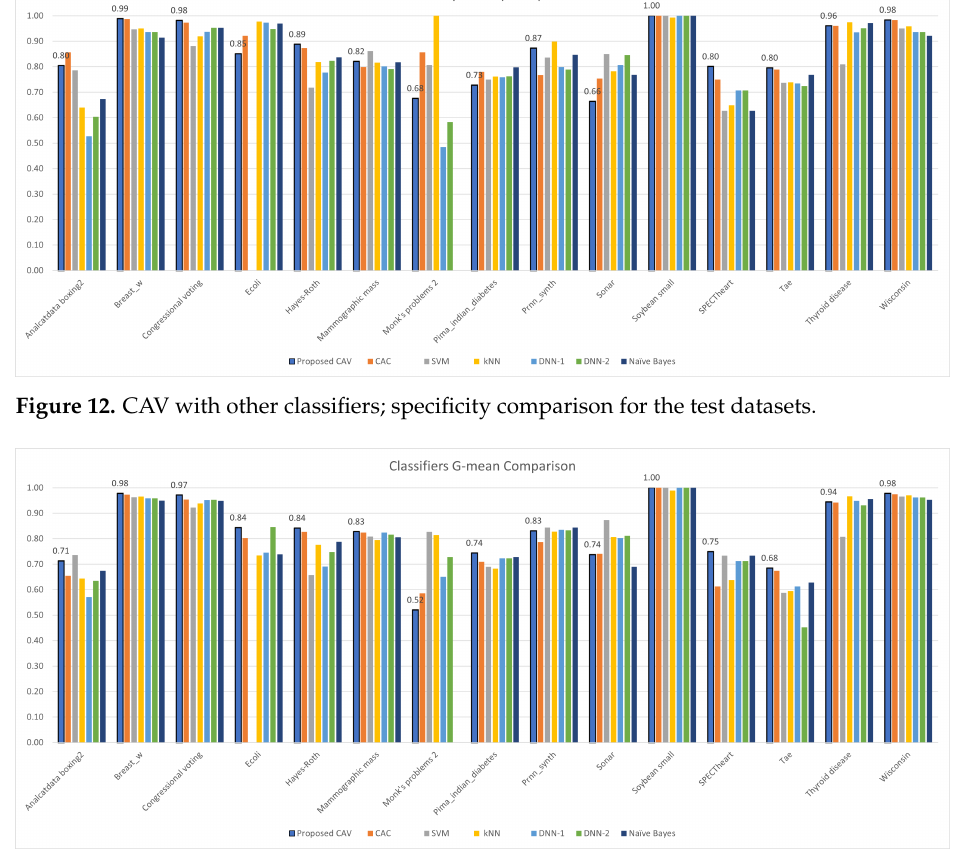
Figure 13. CAV with other classifiers; G-mean comparison for the test